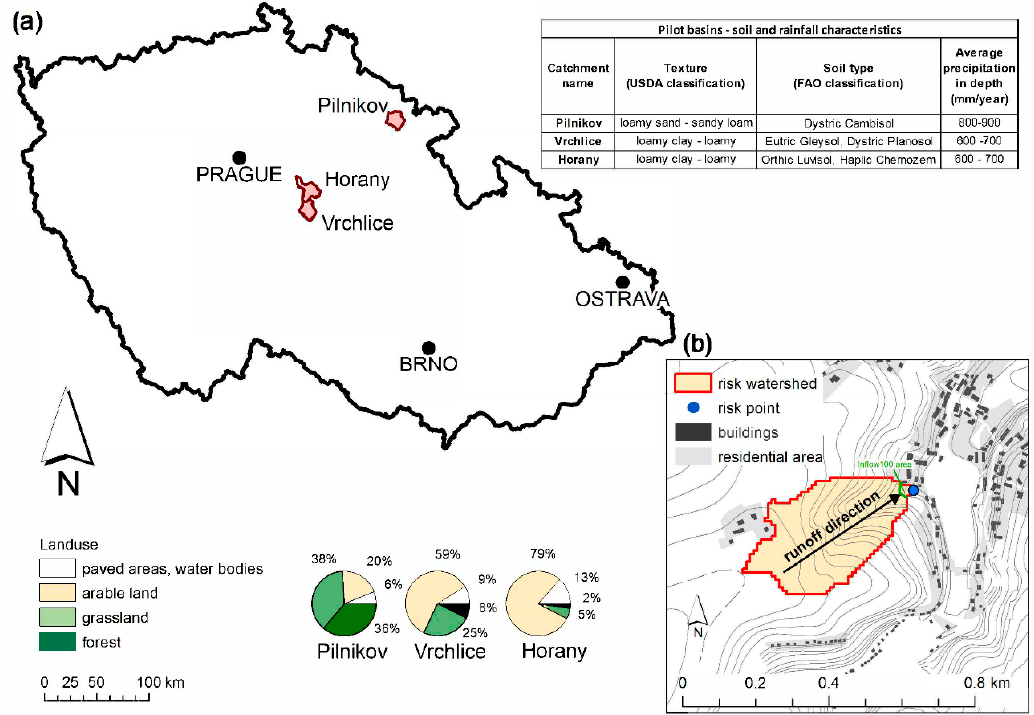
Figure 2. Three research catchments selected for the field survey ( a ). Sediment flux from threat watershed flows into residential area through potentially threatened outlet ( b ).